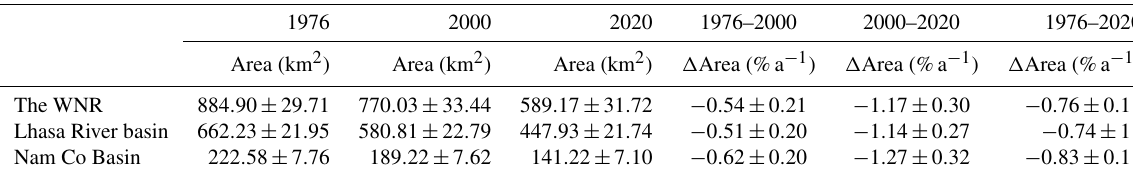
Figure 3. The distribution of glacier area change in the WNR from (a) 1976 to 2000, (b) 2000 to 2020 and (c) 1976 to 2020. Table 1. Glacier area changes over the WNR from 1976 to